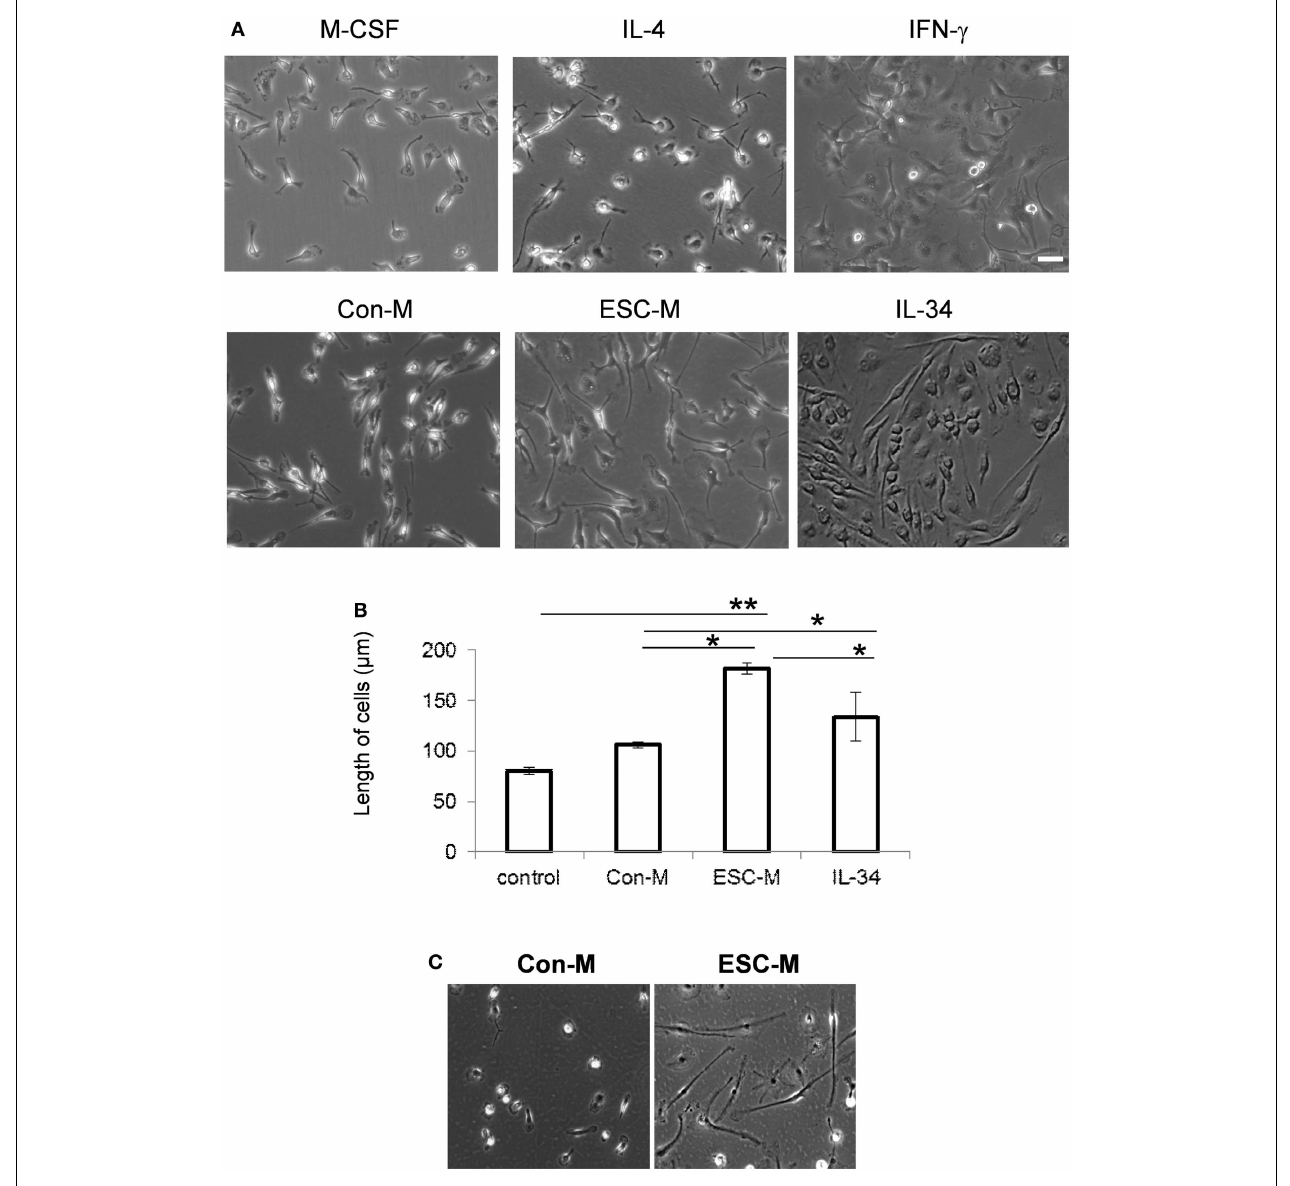
was measured by ImageJ ( n = 6, * p < 0.05, ** p < 0.001, two-sidedWilcoxon test. Data are represented as mean ± SEM). (C) Representative phase-contrast photomicrographs of primary microglial cells incubated with Con-M and ESC-M for 72h. Original magnification, ×